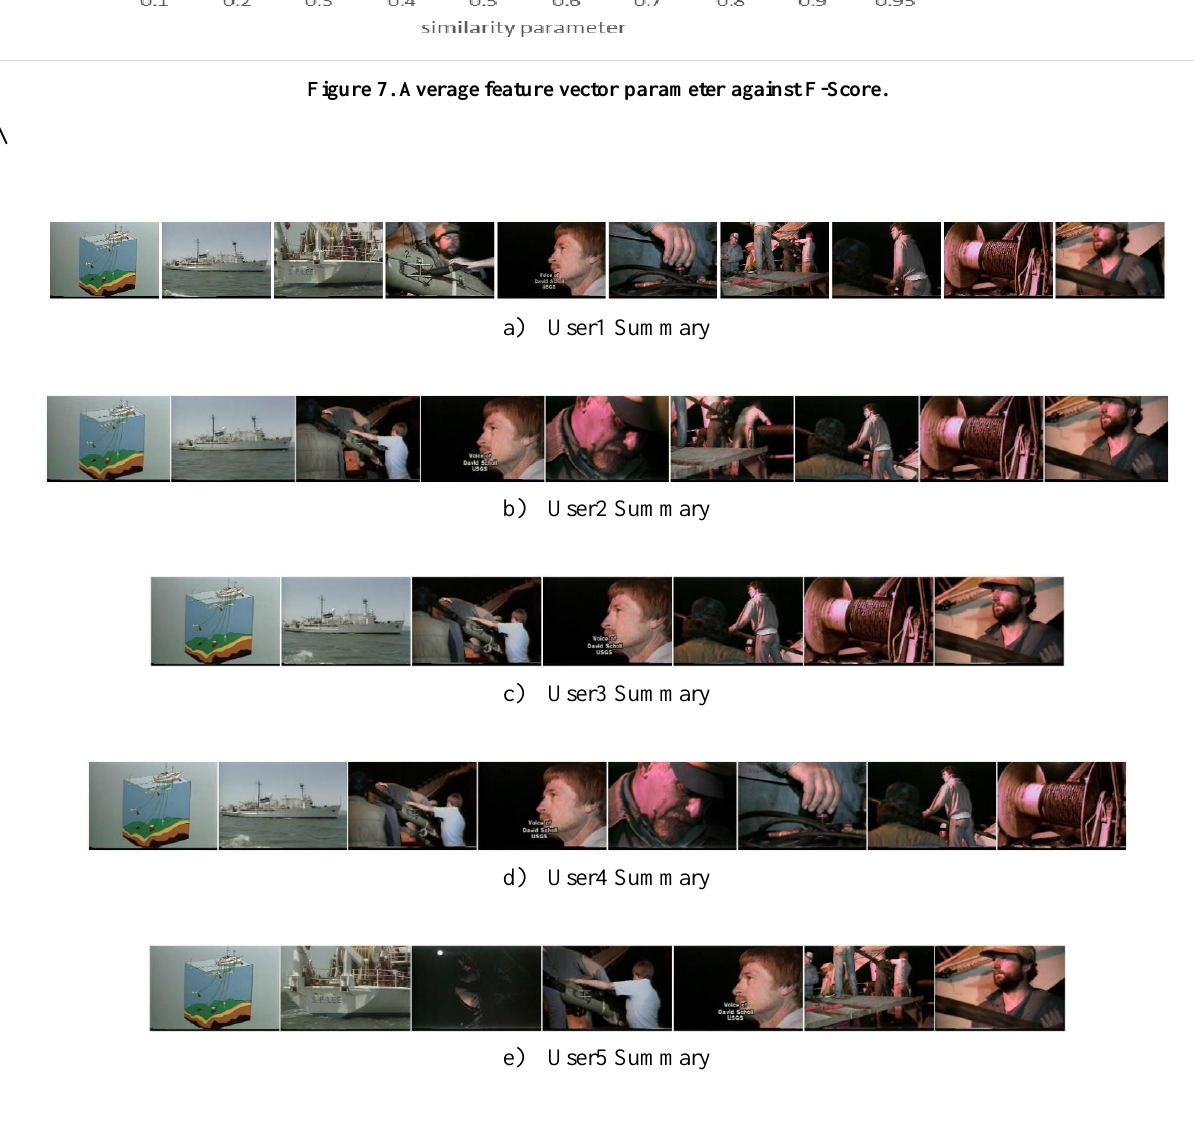
Figure 8. User Summaries of " The voyage of the lee, segment 05 "